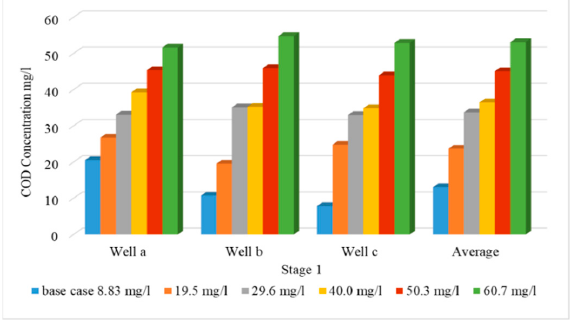
Figure 7. Comparison between COD concentration at observation wells for different scenarios (2–6) of stage 1.